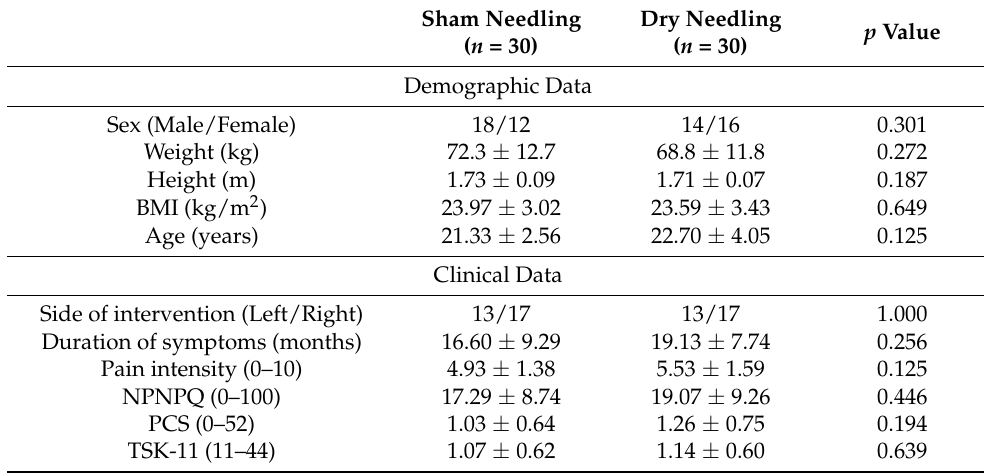
Table 1. Demographic and clinical characteristics of both